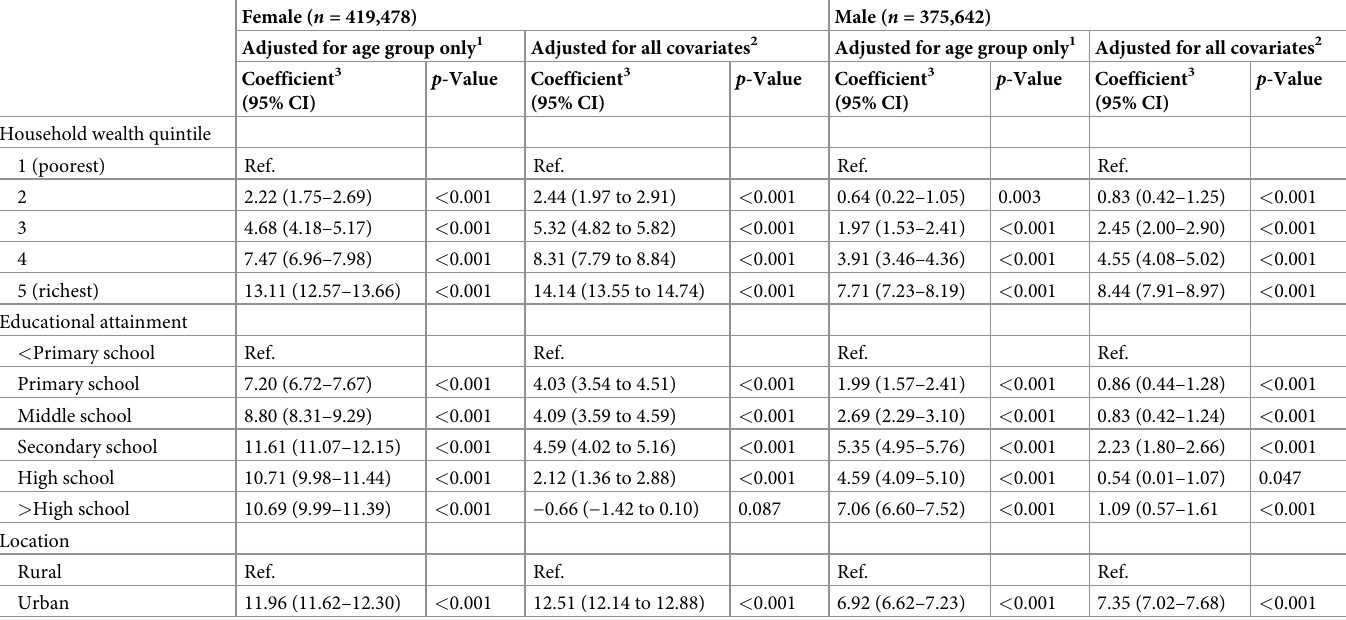
Table 5. Ordinary least squares regressions of the natural logarithm of cardiovascular risk on sociodemographic covariates and a district-level fixed effect. Female ( n =